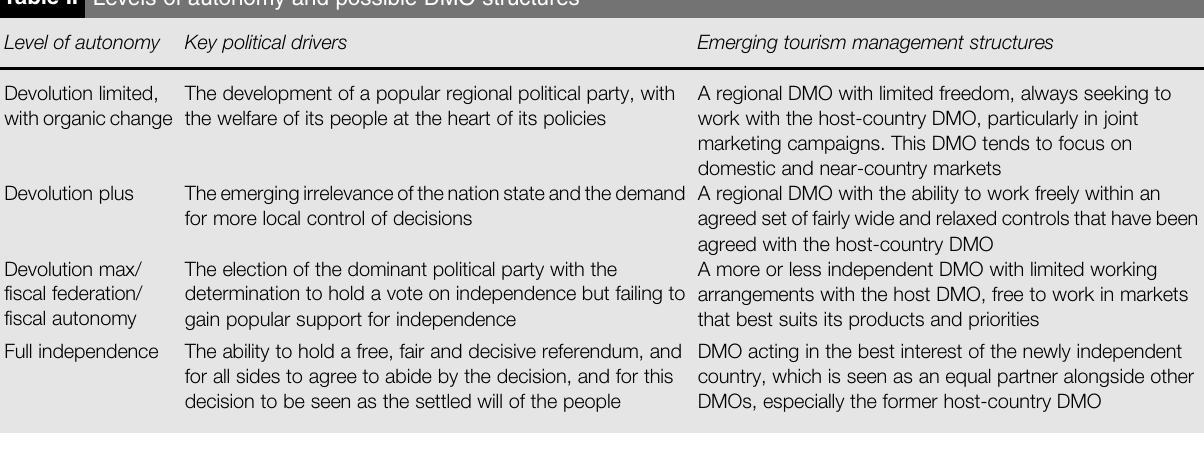
Table II Levels of autonomy and possible DMO